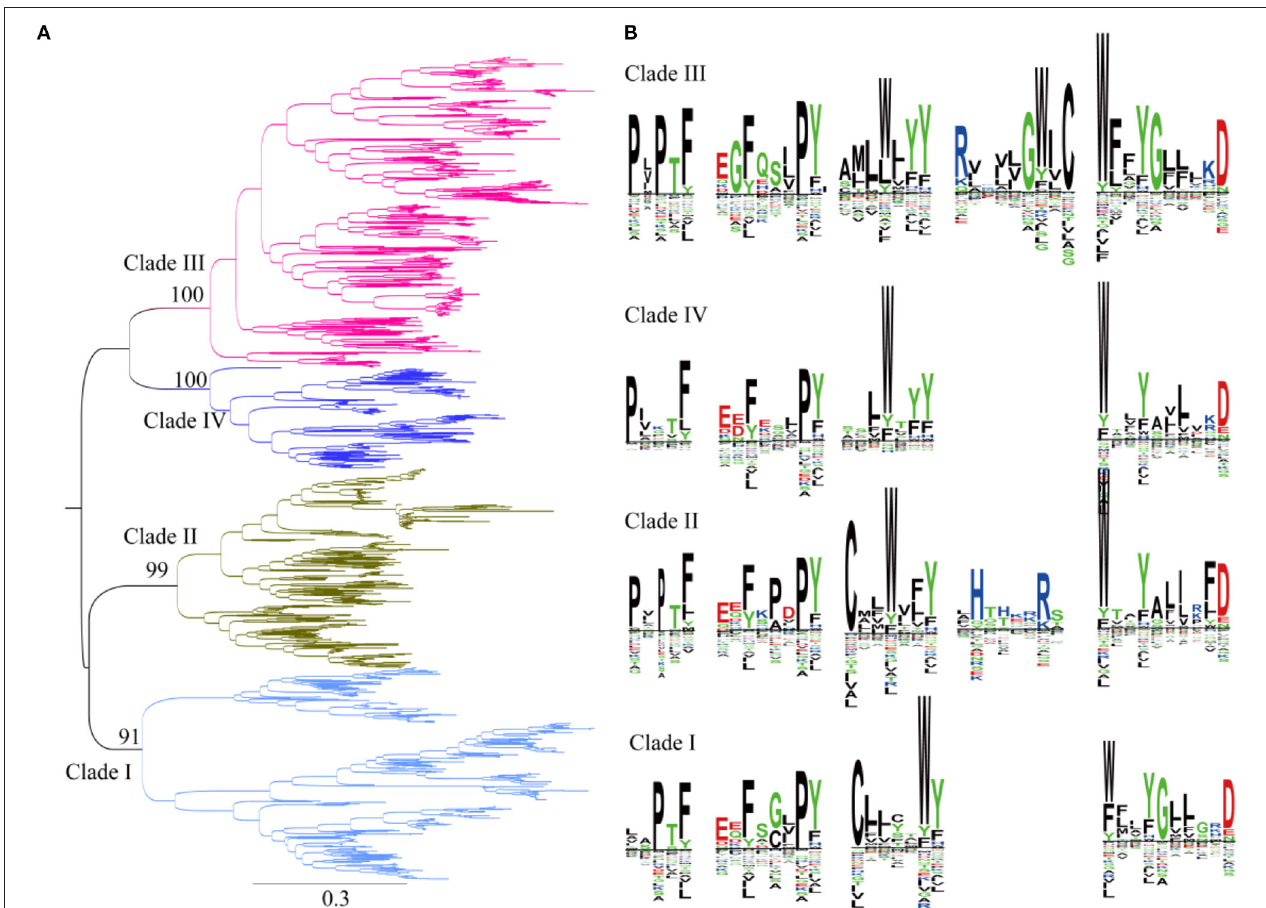
FIGURE 4 | Phylogenetic and conserved motif analyses of SWEETs from green plants. (A) Molecular phylogenetic analysis by the maximum likelihood method. The tree with the highest log likelihood (-261256.9227) is shown. The tree is drawn to scale, with branch lengths indicating the number of substitutions per site. There was a total of 2,335 positions in the final dataset. Evolutionary analyses were conducted in MEGA7. (B) Sequence alignment of conserved motifs of SWEETs in different clades corresponding to (A) . The sequences were aligned by ClustalW. The conservation level of each residue is indicated by the height of the bar above it. The sequence logo was generated using